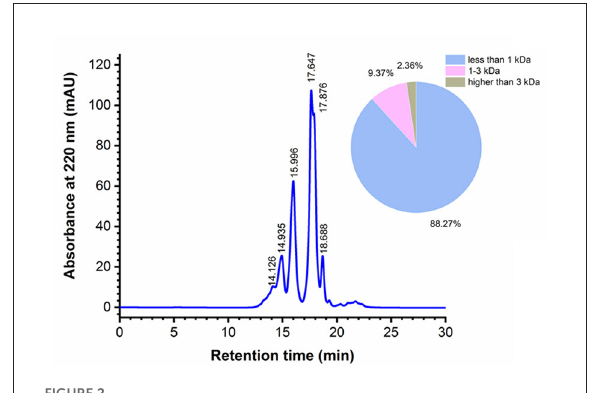
FIGURE2 Molecular weight (MW) distribution of